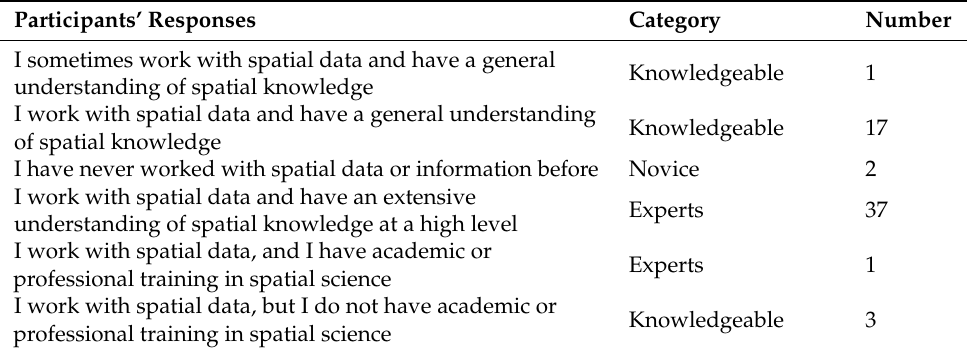
Table 3. Participants’ levels of spatial knowledge.